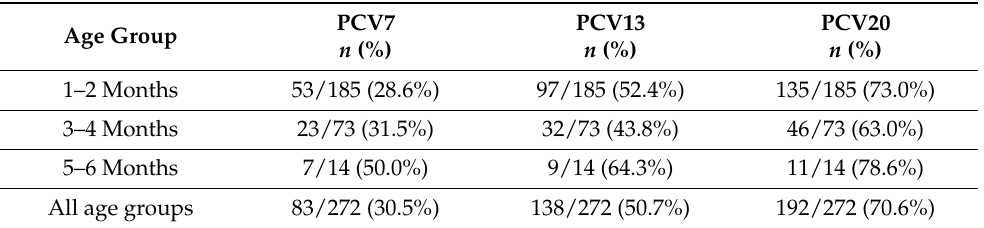
Table 3. Coverage of the pneumococcal conjugate vaccines in each age group.